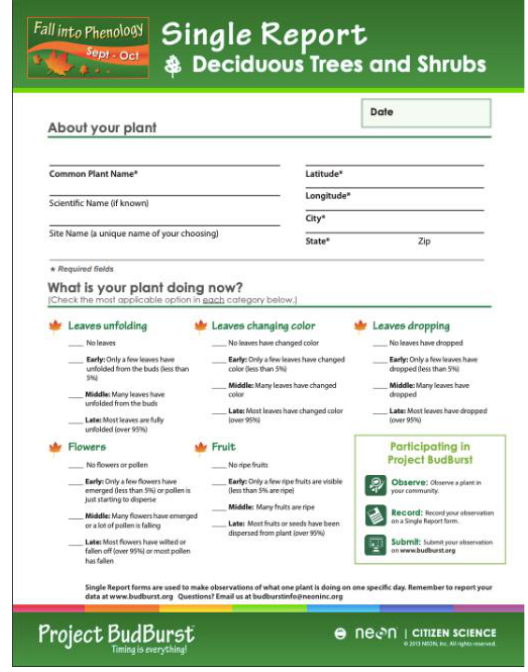
Figure 2. Phenology data form used by the students enrolled in the applied remote sensing course at University of Wyoming for tracking leaf color change and drop of deciduous trees. This form was developed by National Ecology Observation Network (NEON) as part of the Project BudBurst